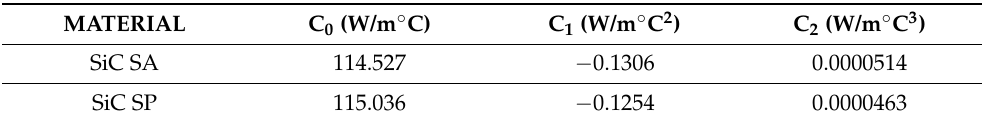
Table 3. C 0 , C 1 and C 2 parameters (see Equations (1) and (2)) for the Hexoloy ® silicon carbides SA